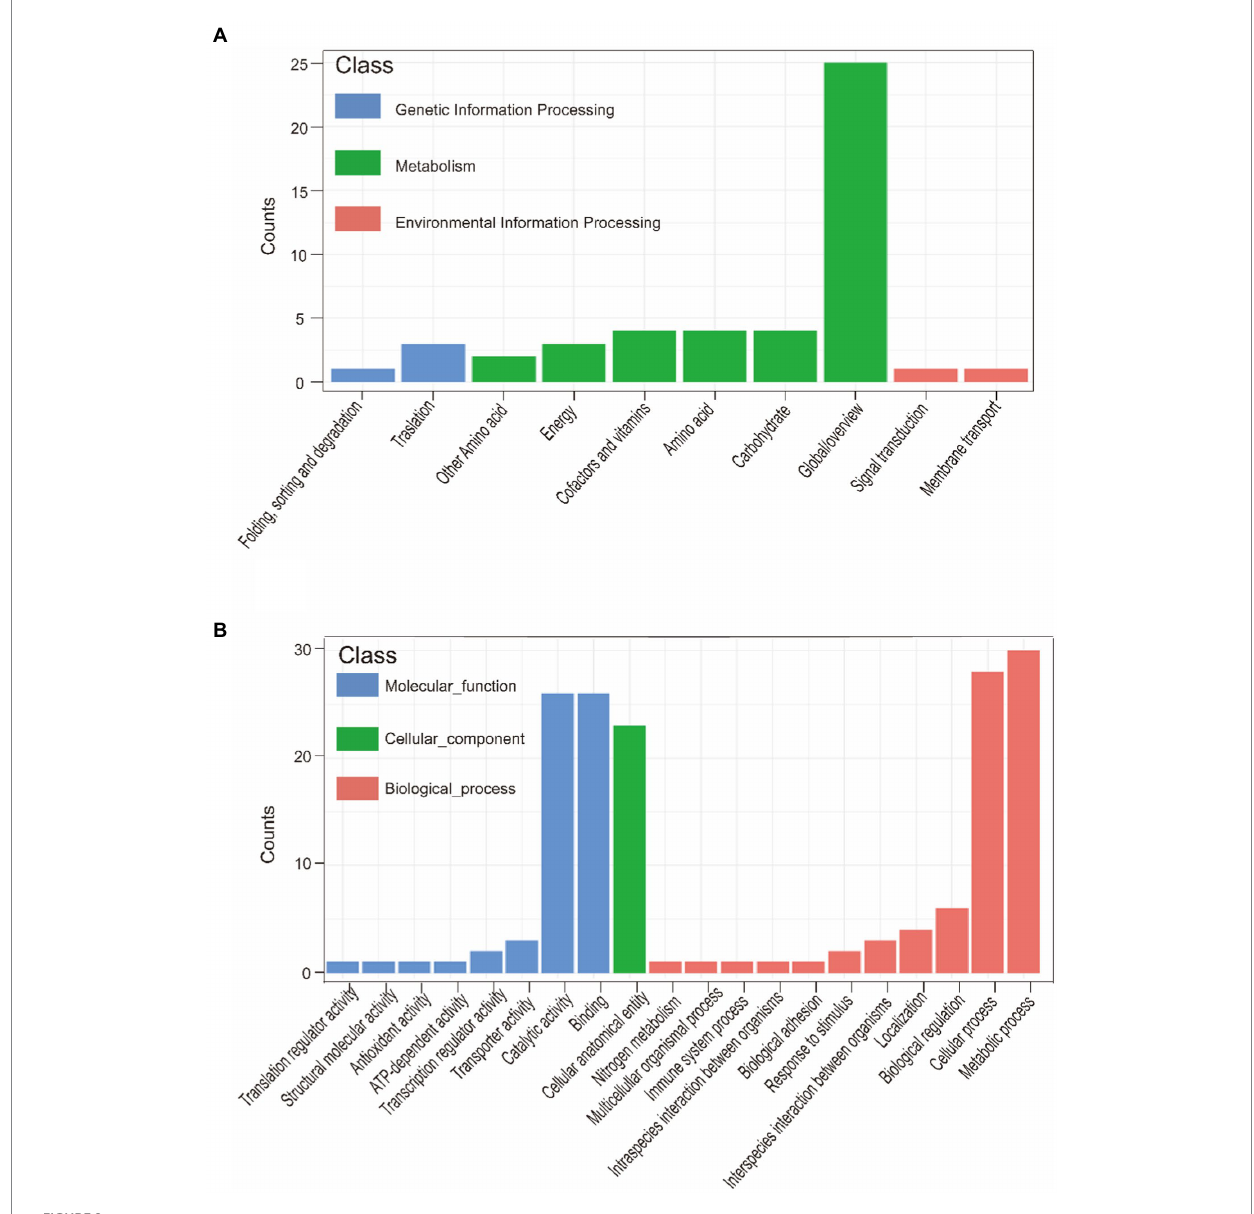
FIGURE 9 KEGG annotation of biofilm formation-associated genes (A) . GO annotation of biofilm formation-associated genes (B)